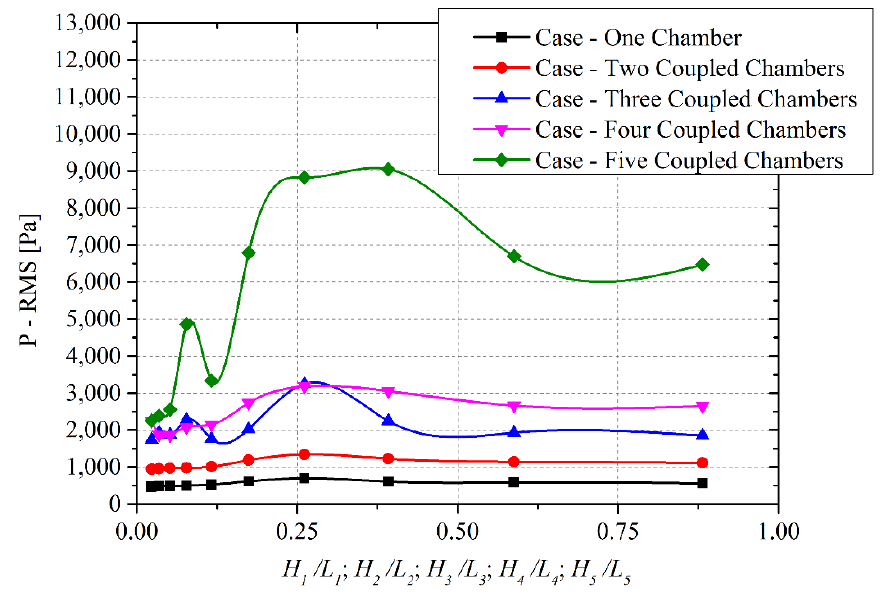
Figure 10. Accumulated pressure in each coupled device.